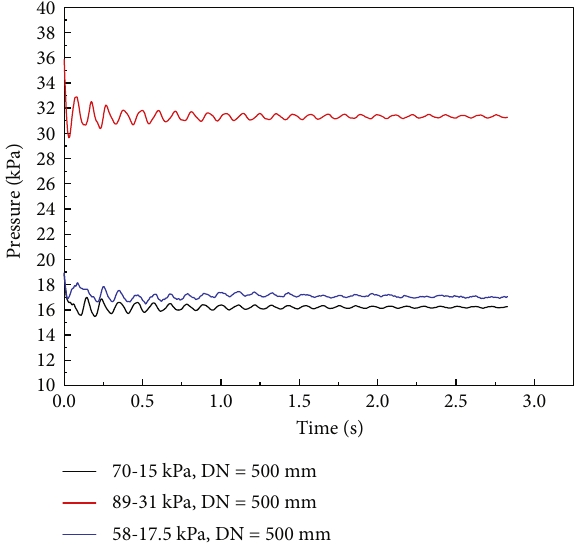
Figure 15: Rapid decompression and balancing process when DN = 500 mm .